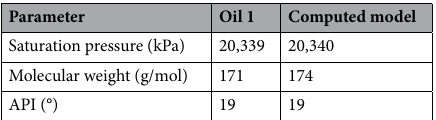
Table 2. Oil properties of Burke Oil 1 data and the computed model.